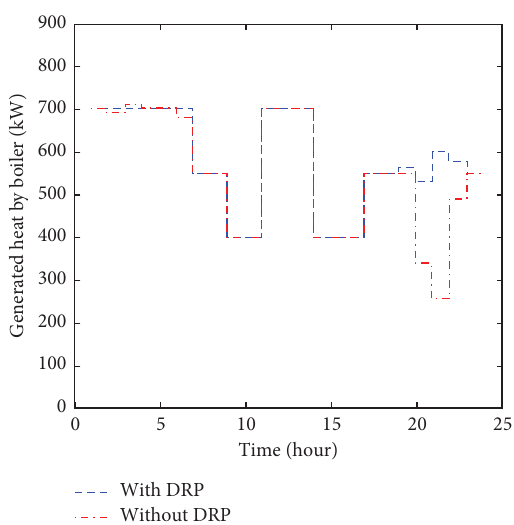
Figure 13: Te heat generated by the boiler.